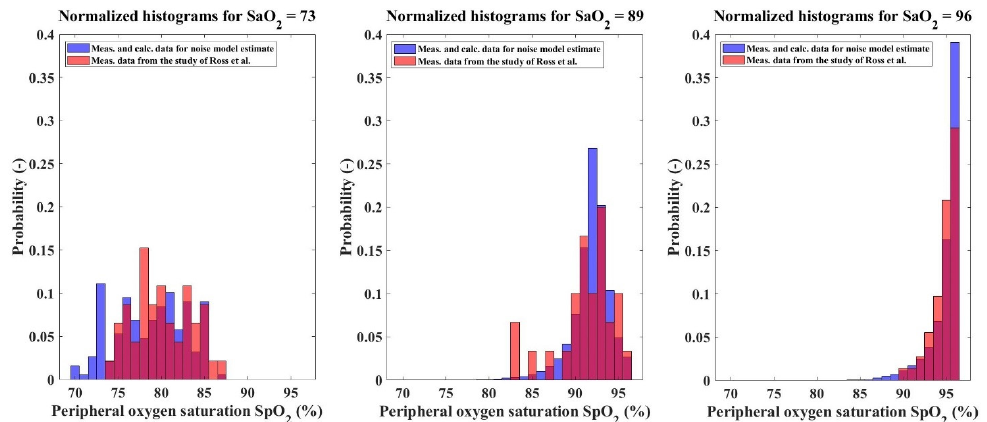
Figure 7. An example of partially overlapping histograms for three different SaO 2 units and the window size of the median filter set at 227 samples. The blue color represents the SpO 2 values measured to estimate the SpO 2 measurement noise. The red color represents the SpO 2 values acquired by Ross et al. [11]. The magenta color represents the histogram